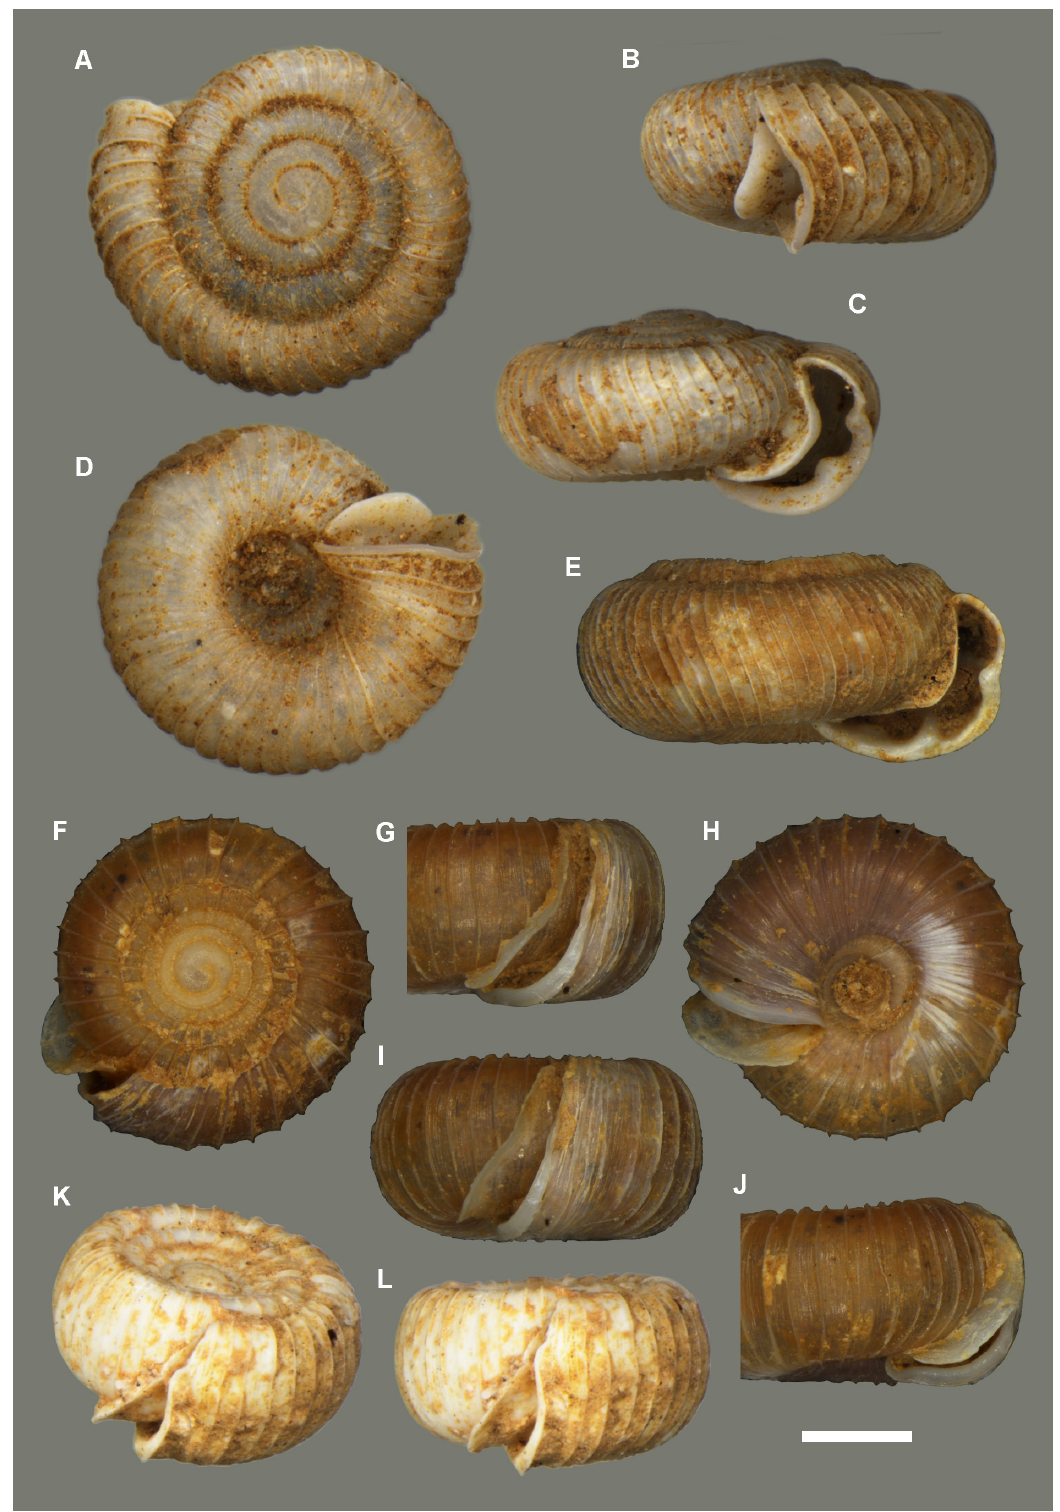
Fig. 3. Shells of species of Virpazaria Gittenberger, 1969. A–E . Virpazaria (Virpazaria) deeleman- orum dhorai Reischütz et al. , 2010. A–D. Holotype (NHMW 107224). E. Drisht (HNHM 103421). F–L . Virpazaria (Virpazaria) stojaspali Reischütz et al. , 2009. F–J. Štegvaš Pass (HNHM 103441). K–L. Holotype (NHMW 106690). Scale bar = 1